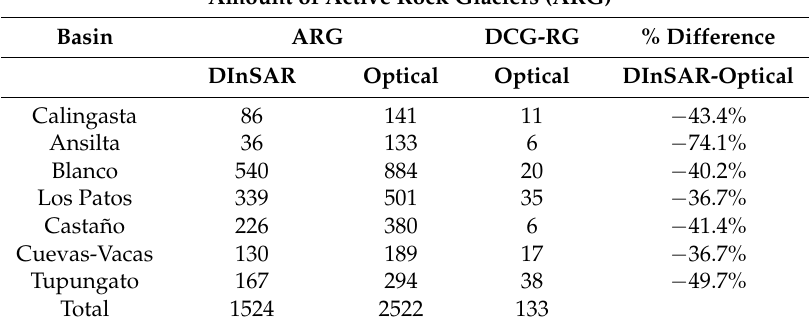
Detected active rock glaciers with DInSAR and optical techniques in the different studied basins. The acronym meanings are: ARG: Active Rock Glacier; DCG-RG: Debris-covered Glacier-Rock